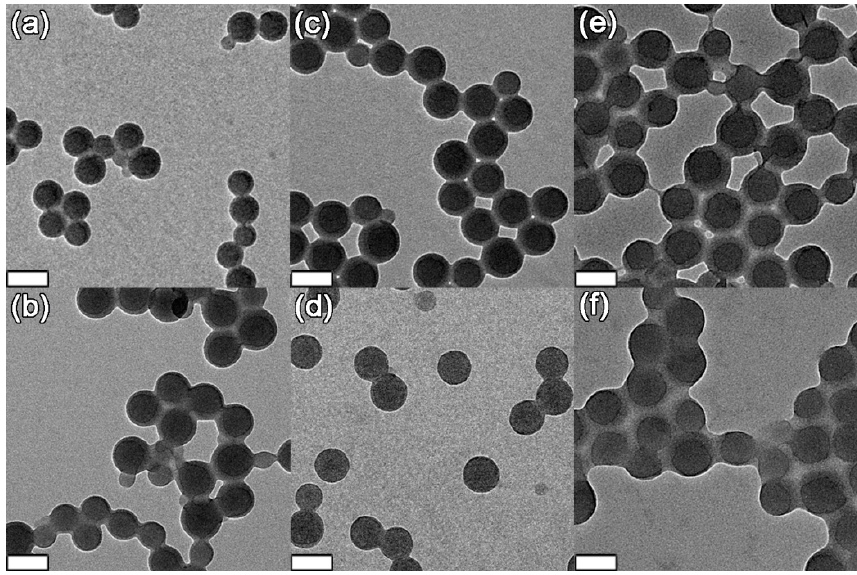
Figure 1. Transmission electron Microscopy (TEM) images of ( a ) PS, ( b ) PSV, ( c ) PSV@PNIPA, ( d ) PSV@PAA, ( e ) PSV@PNIPA-b-PAA, and ( f ) PSV@PAA-b-PNIPA. Scale bar = 100 nm.